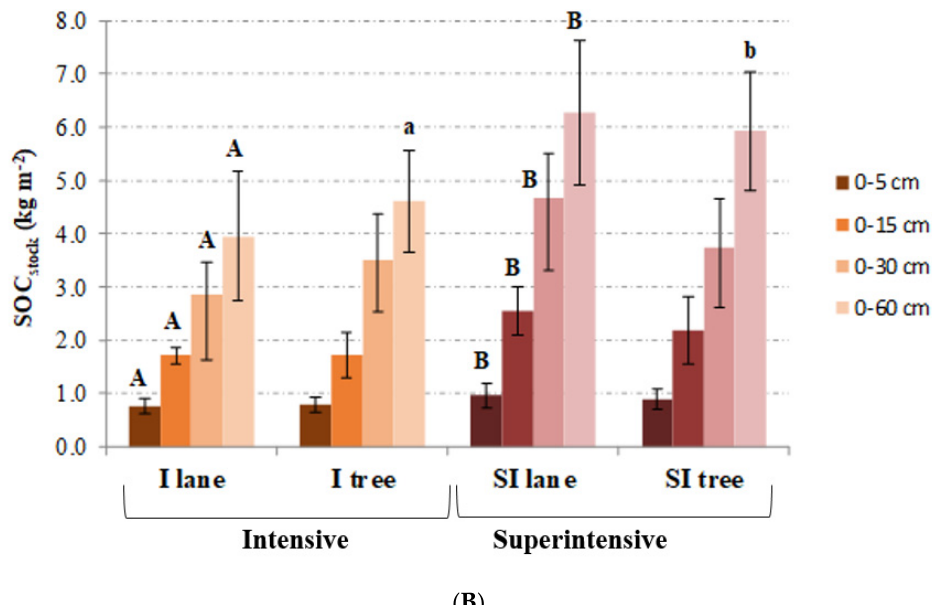
Figure 4. ( A ) Soil organic carbon concentration (SOC; %) and ( B ) cumulative soil organic carbon stock (SOC stock ; kg m − 2 ) by soil depth and location (lane or tree) within the two olive orchards (I: intensive; SI: superintensive) for the soil sampling carried out in 2018. Different letters indicate statistically significant differences ( p < 0.05, using a Kruskal–Wallis test) between the two orchards for the same depth and location (lane, capital letters, or tree, lowercase letters). Error bars are standard deviation, n = 8.